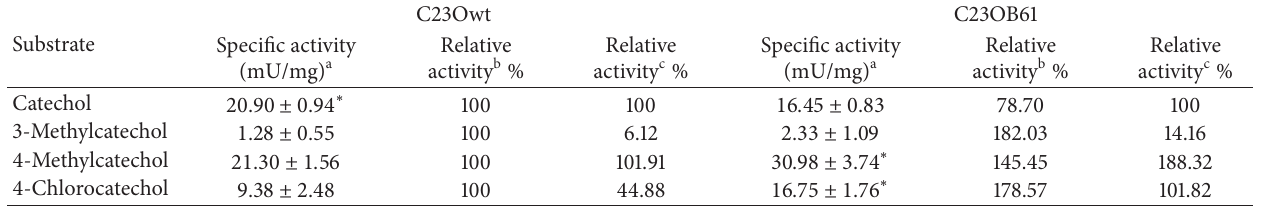
Table 2: Specific and relative activity of wild-type (wt) and mutant C23O dioxygenases using different catechols as the substrate. Substrate